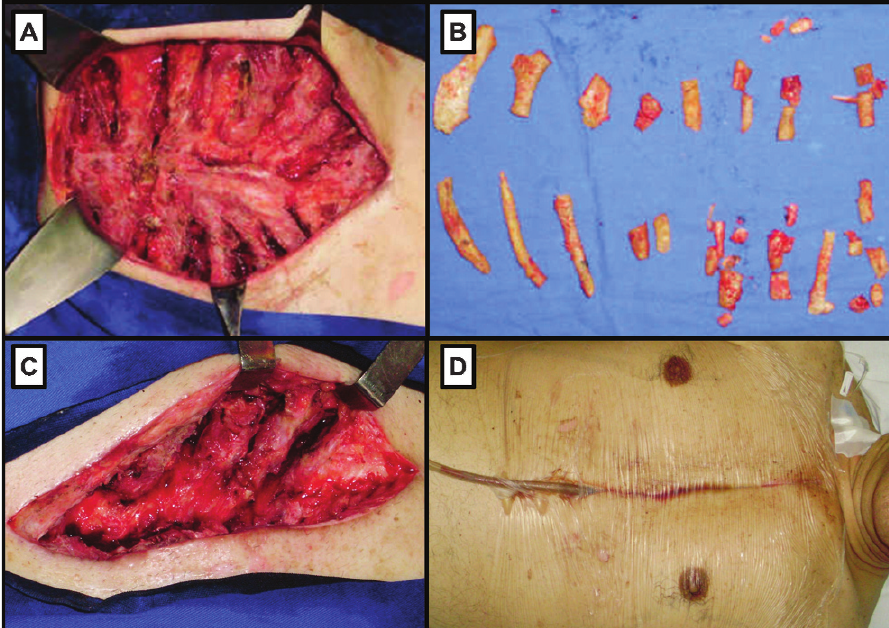
Figure 1 - A) Bilateral infection in the 3 rd to 8 th costal cartilages and ribs. B ) 3 rd to 8 th bilateral costal cartilage removal. C ) Second bilateral debridement of the 6 th ribs on the 4 th post-operative day. D ) Final apperance of the wound with insertion of a Portovac